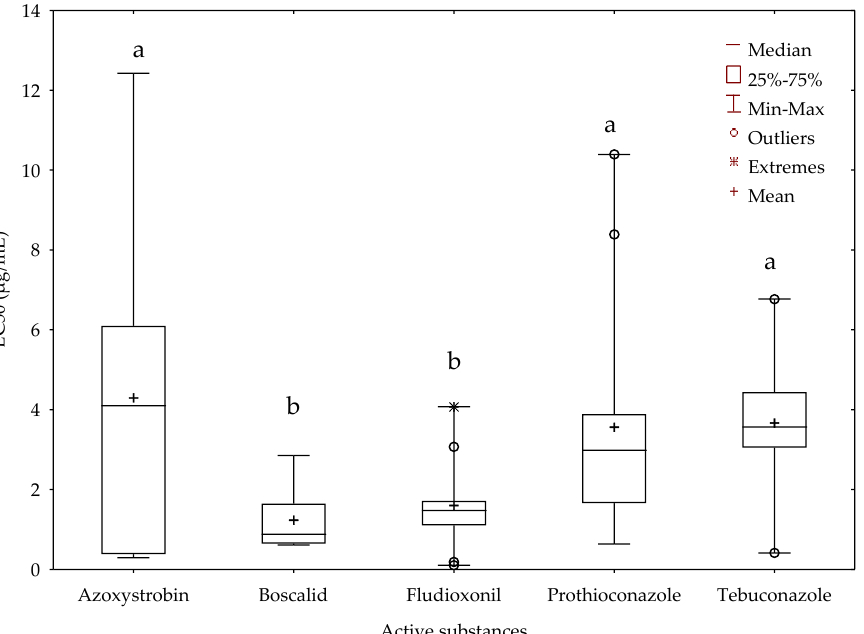
Figure 1. Distribution of EC50 values of Sclerotinia sclerotiorum isolates ( n = 68) to various active substances. Data are presented as box-whisker plots with 25% and 75% quartiles (boxes), minimum and maximum values (whiskers), median (central line) and mean values of all isolates (plus sign). All circles above or below of each box plot represent outliers, stars represent extreme values. Means followed by the same letter were not different according to Fisher’s least significant difference at p ≤ 0.05.